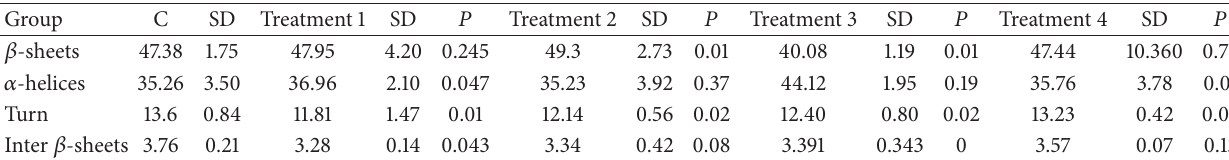
Table 3: Curve-fitting results of bands in 1700–1800 cm −1